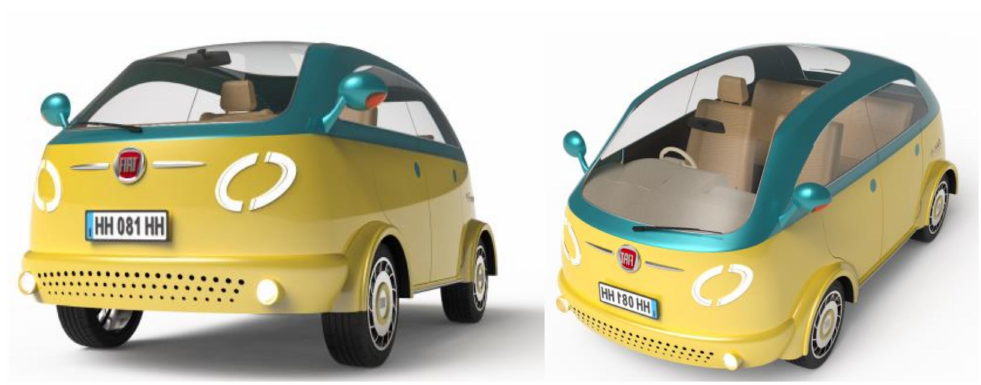
Figure 29. New FIAT 600 Omega—CAD 3D model: complete car.